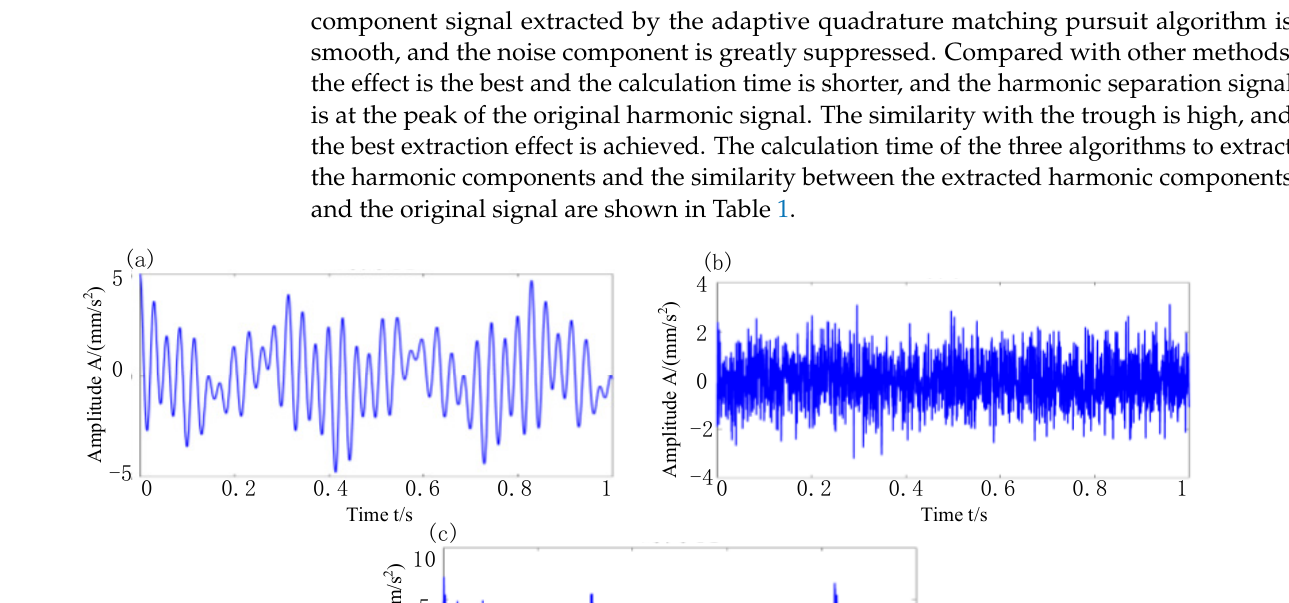
Processes 2022 , 10 , x FOR PEER REVIEW 10 of 24 Figure 4. Synthetic signal time-domain waveform. ( a ) Harmonic signal; ( b ) noise; ( c ) composite signal.